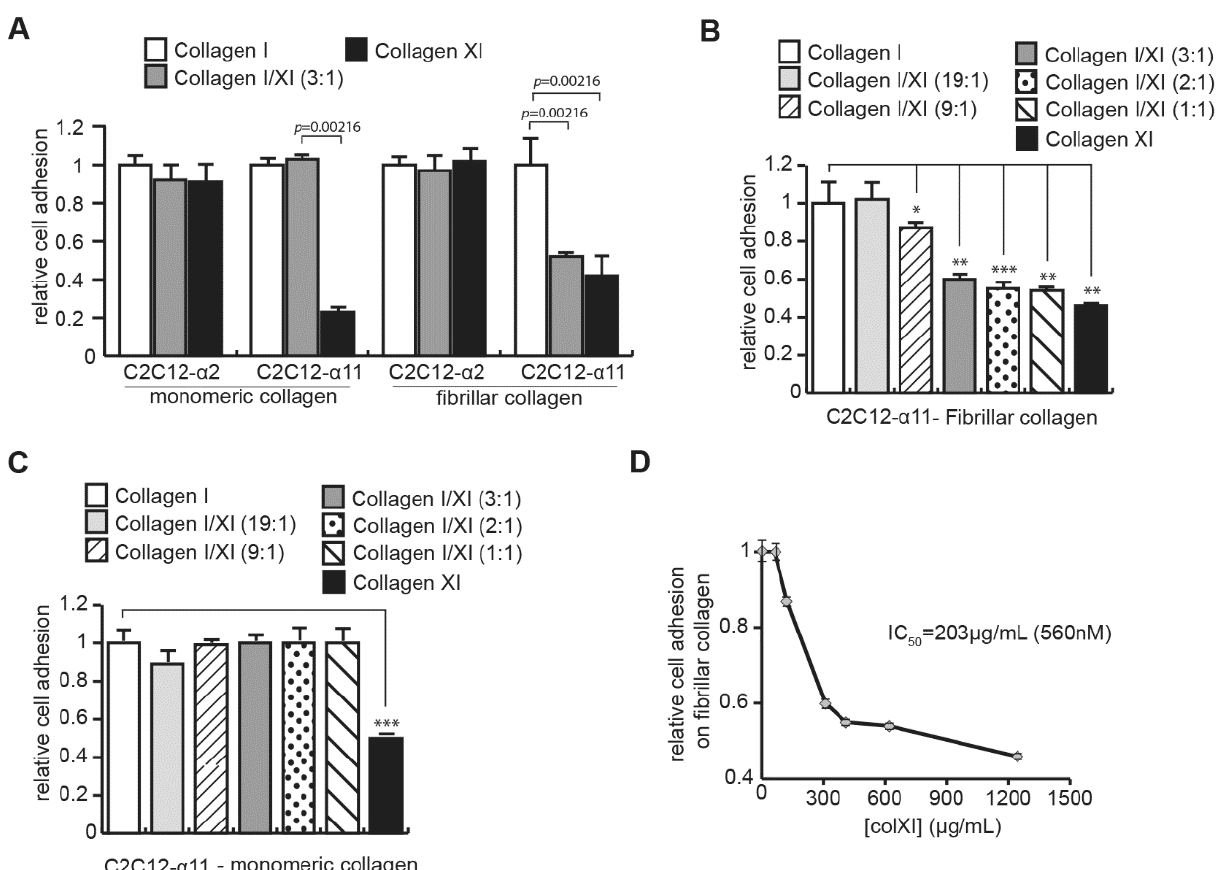
Figure 3. Collagen type XI restrains integrin-binding site availability on collagen type I. ( A ) Collagen type XI inhibits C2C12- α 11 binding on fibrillar collagen type I. C2C12 cells expressing either integ- rin α 2 (C2C12- α 2) or integrin α 11 (C2C12- α 11) were seeded on monomeric or fibrillar collagen type